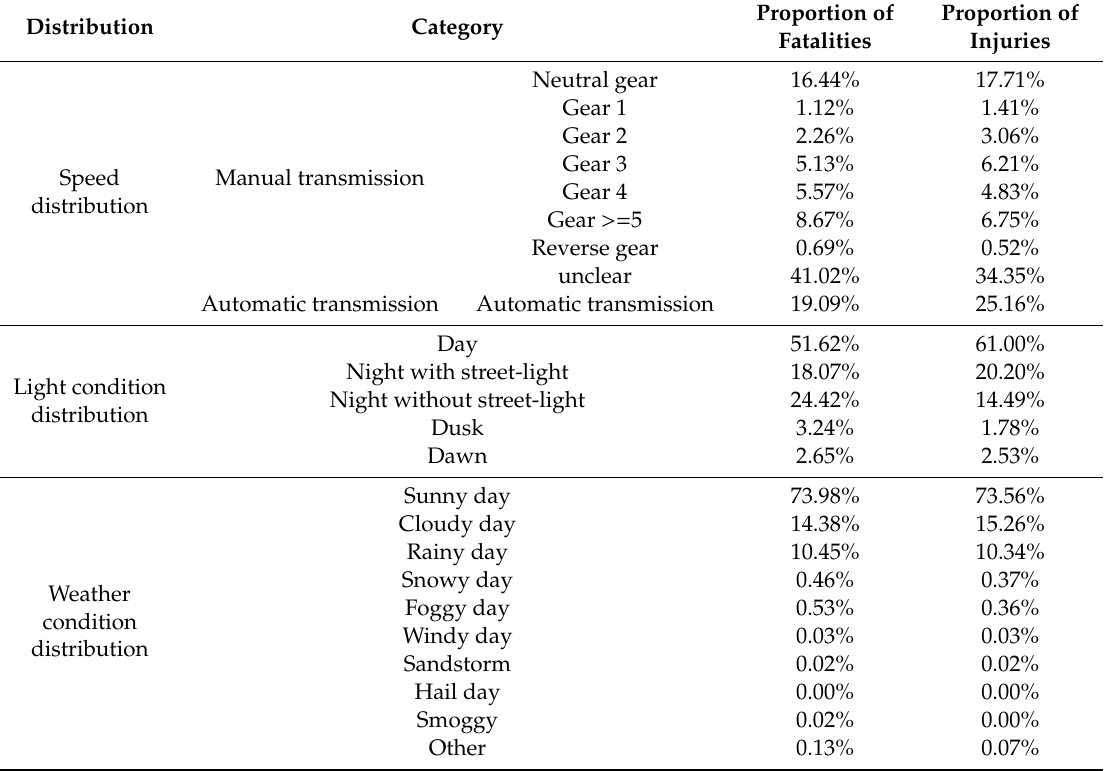
Table 2. The distribution of gear, light, and weather in China’s collisions in